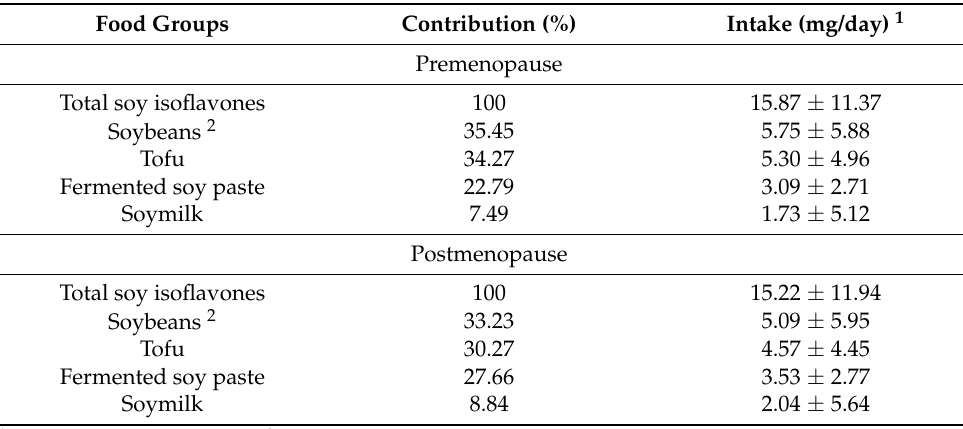
Table 2. Contribution of food groups to dietary soy isoflavones among